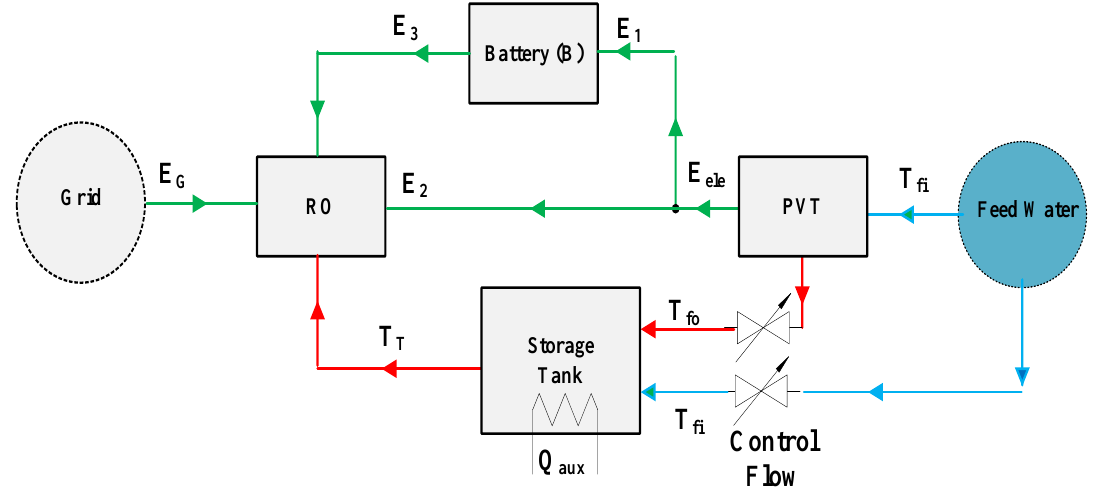
Figure 1. Diagram for PVT- and RO-based technology system for water desalination plant (T refer for thermal and E refer for electrical energy)